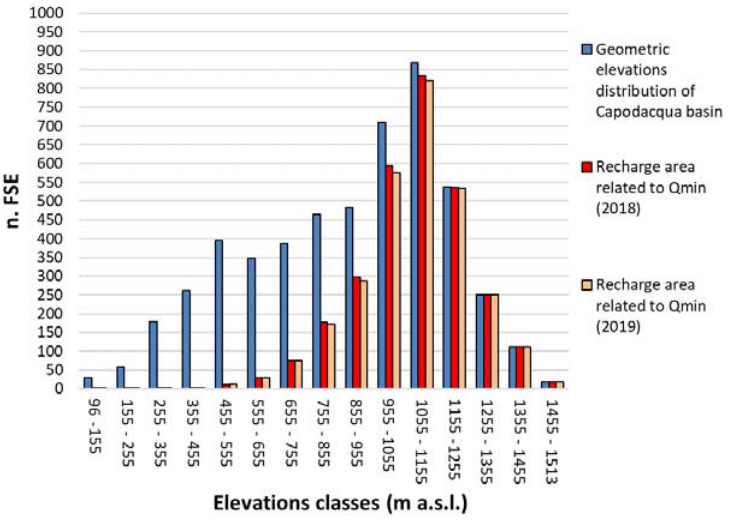
Figure 12. Recharge areas distribution simulated by the model defined by Iacurto et al. [21].